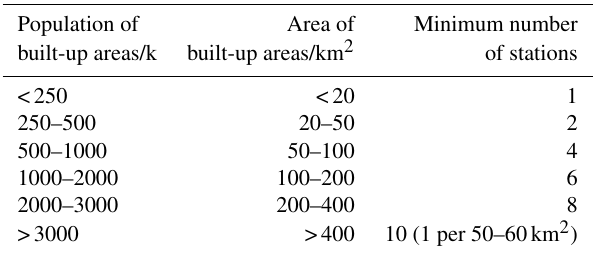
Table 1. The requirement for the minimum number of urban sta-